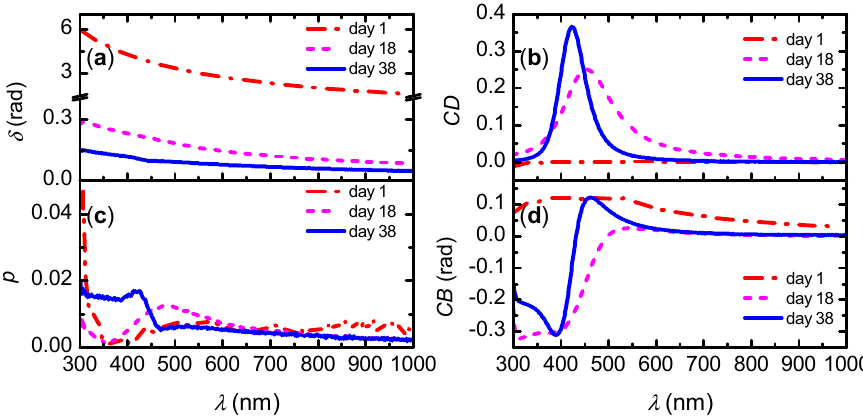
Figure 8. Polarization properties of CNC films prepared from non-sonicated suspensions stored for the indicated number of days: ( a ) retardation δ , ( b ) circular dichroism CD , ( c ) attenuation p , and ( d ) circular birefringence CB . Notice the change of scale in the vertical axis in ( a ).